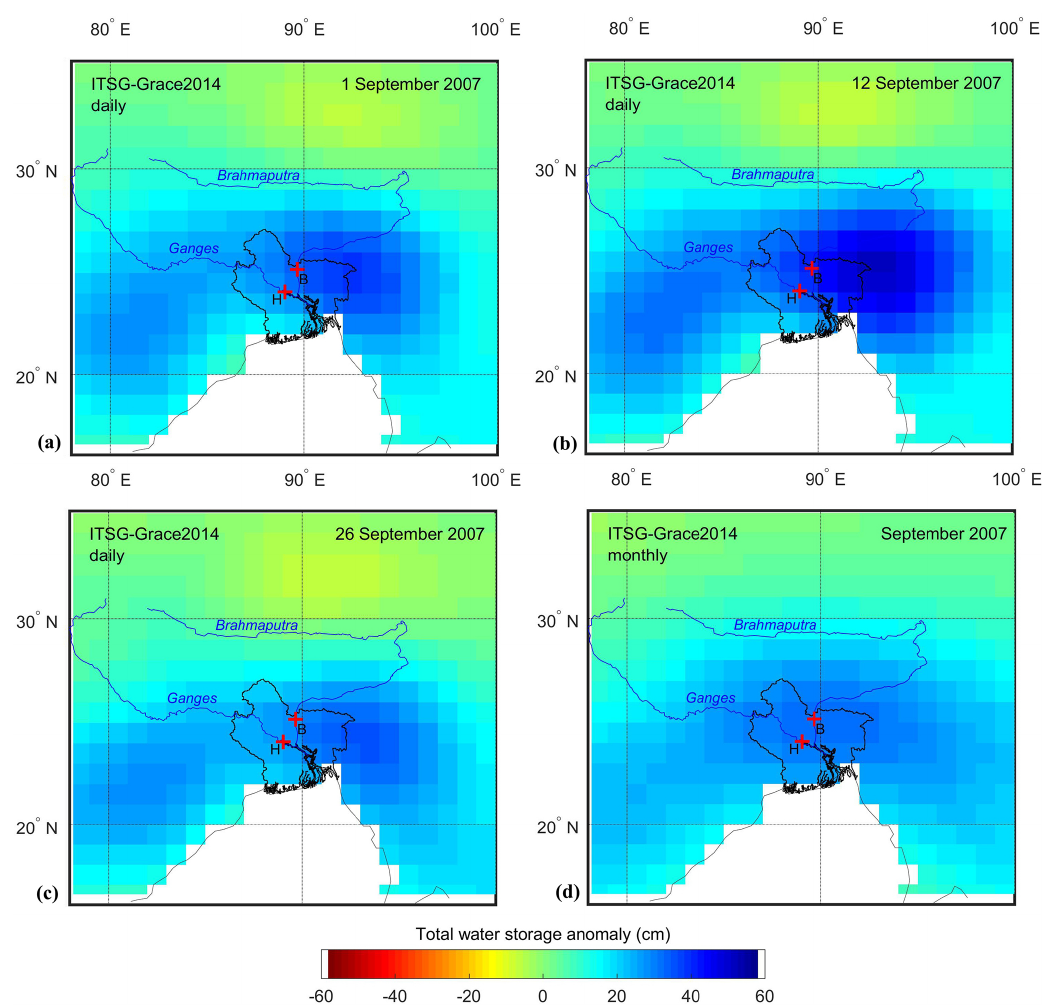
Figure 7. Daily and monthly water storage anomalies of the ITSG-Grace2014 solution for the Ganges–Brahmaputra Delta on (a) 1 Septem- ber 2007, (b) 12 September 2007, (c) 26 September 2007 and (d) September 2007. Key is as in Fig.